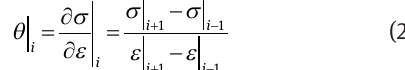
Fig. 6: Typical DRX flow stress curve at 1150 °C and 0.01 s − 1 divided into four stages (1. working hardening stage, 2. transition stage, 3. softening stage and 4. steady stage).